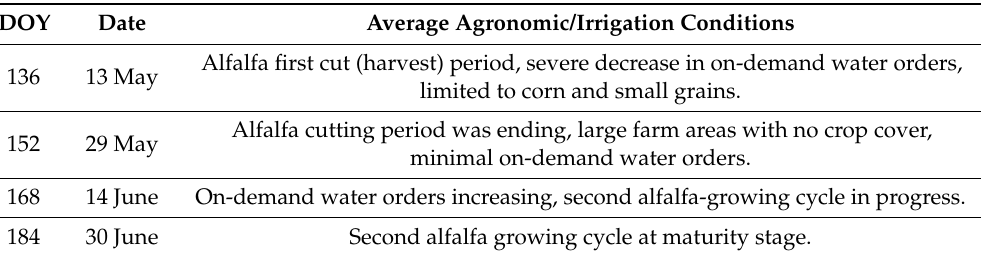
Table 1. Landsat 7 ETM+ images used for this